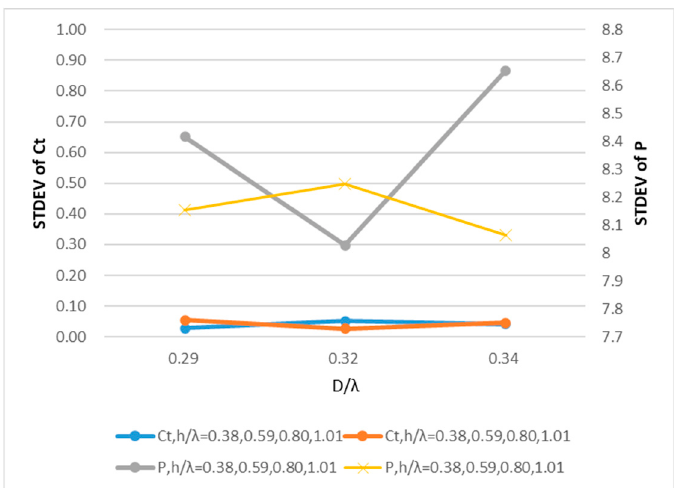
Figure 11. Standard Deviation Analysis